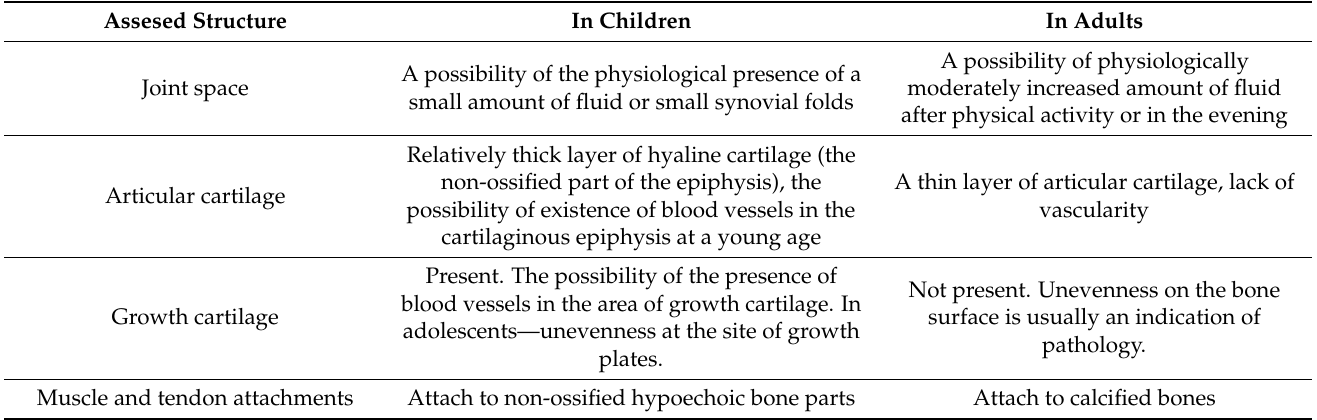
Figure 7. Examples of increased flow in Power Doppler imaging in children, which do not correspond to a pathology. ( a ) Frontal plane scan from the side—visible vessels within hyaline cartilage of the epiphysis of the femur of a 6-month-old boy. Linear probe 3–19 MHz. ( b ) Longitudinal scan of the suprapatellar recess of the same child—visible vessels near the growth plate. ( c ) Longitudinal scan of the posterior-medial part of the knee joint of a 9-year-old girl. Visible flow in vessels in the pericapsular zone of the posterior part of the medial meniscus. Linear probe 3–12 MHz. ( d ) Longitudinal scan of the anterior recess of the ankle joint of a 5-month-old boy. The visible signals are artifacts from excessive motion. Linear probe 10–25 MHz. Table 1. Basic differences in imaging of healthy tissues within the musculoskeletal system in children and